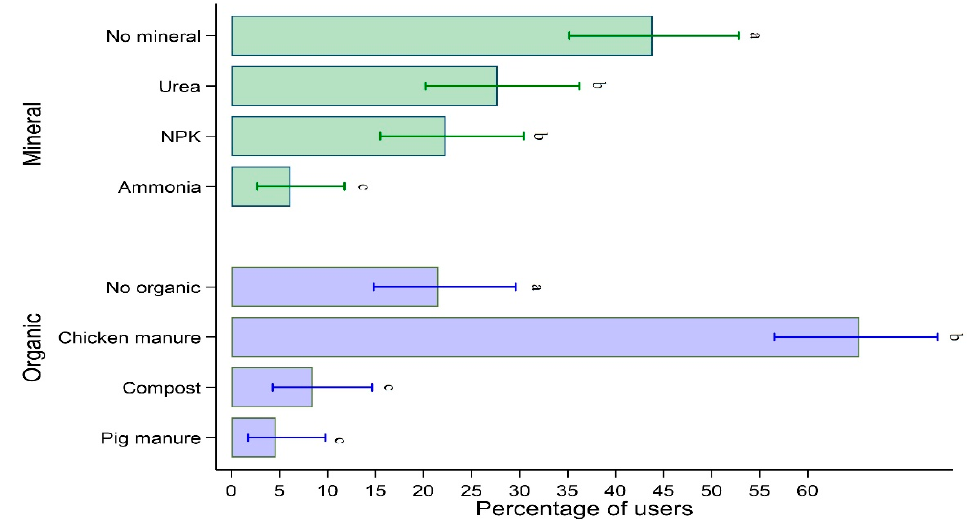
Figure 4. Types of fertilizers used in Yaoundé lowlands (No mineral: farmers use only organic fertilizers; No organic: farmers use only mineral fertilizers; same letter for the respective fertilizer types are not significantly different at p < 0.05 at 95% exact confidence intervals).